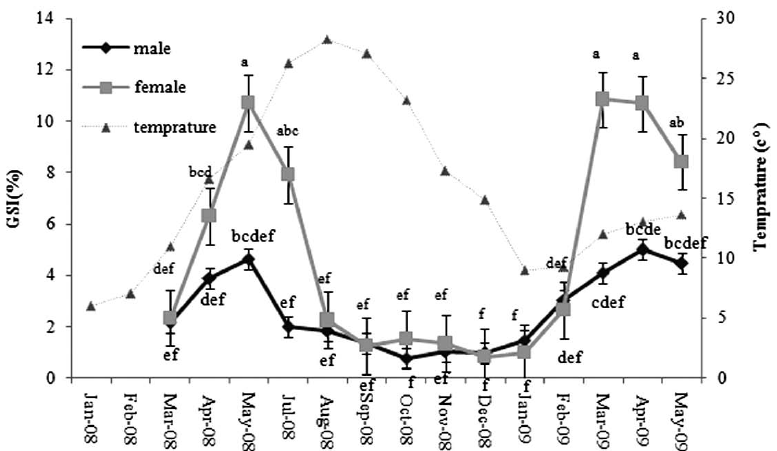
Fig . 2. – Monthly changes in the gonadosomatic index of common kilka and in the average water surface temperatures in the southwest of the Caspian Sea. Values represent the mean ± SE. Means sharing the same letter are not significantly different.